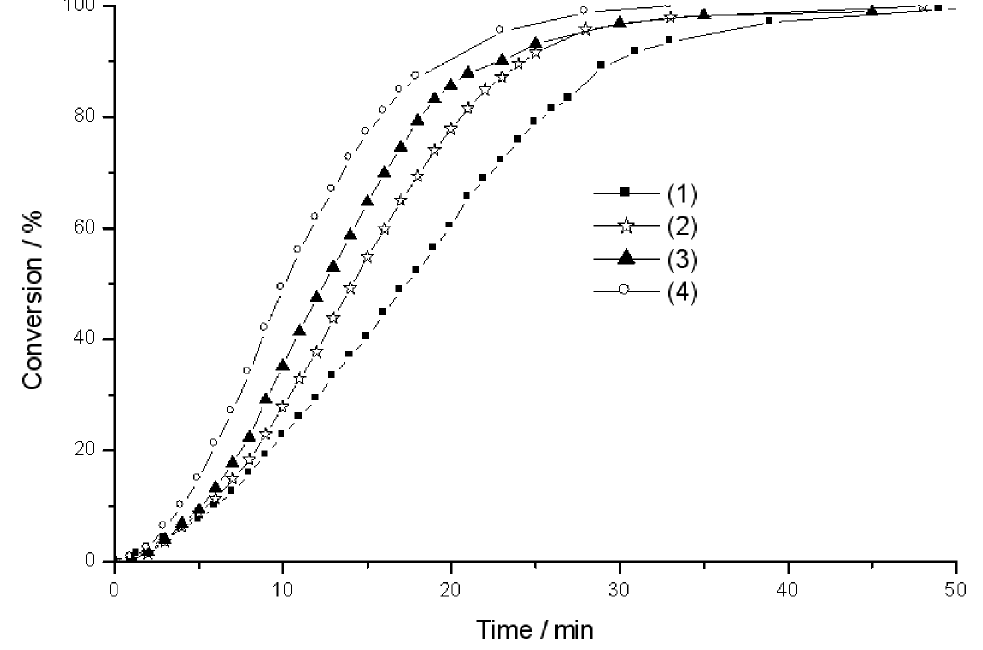
Fig. 4 Variation of monomer conversion in the inverse (mini)emulsion copolymerization of AAm and MA with MBA concentration and reaction time. Recipe: 100 g cyclohexane, 35 g water, 5 g AAm (2.0 mol.dm ¡ 3 water ), 1.3 g MA (0.43 mol.dm ¡ 3 ), 15 g Tween 85, 0.104 g APS, 60 water o C. [MBA] /g: 0.1(1), 0.3 (2), 0.5 (3), 0.7